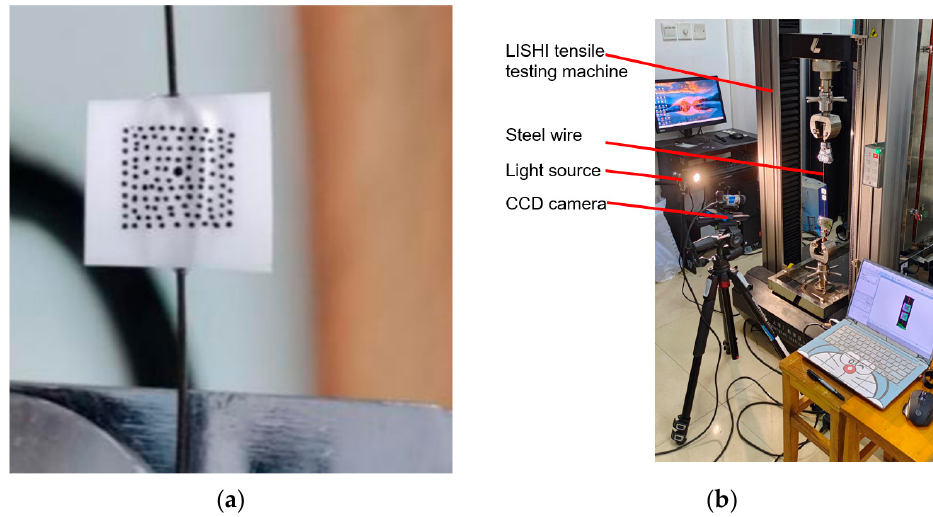
Figure 2. Testing specimens and equipment: ( a ) Speckle image of a single steel wire; ( b ) Testing machine with the 2D DIC system.